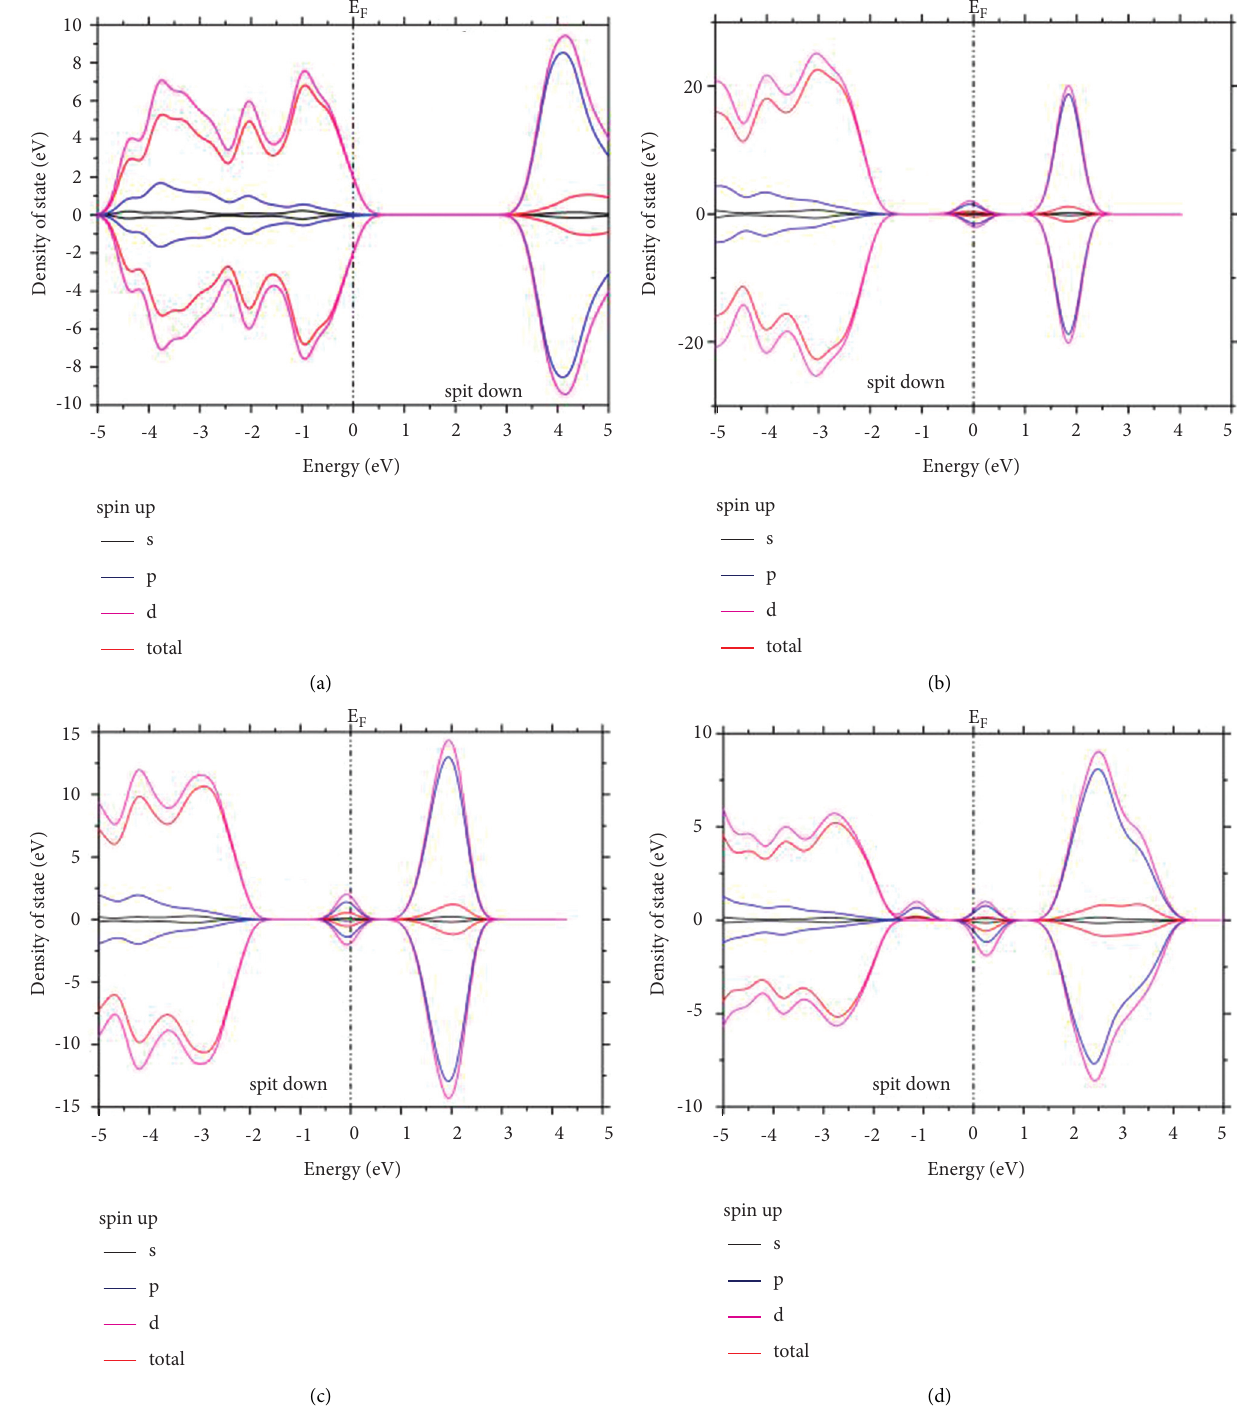
Figure 12: Spin density of states near the Fermi level for anatase TiO 12.5%